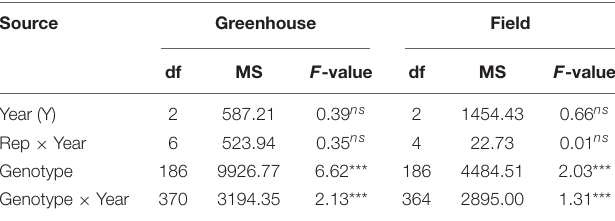
TABLE 2 | Analysis of variance results for FHB severity measured across greenhouse and field environments in 187 Wheaton/Surpresa RILs. Source